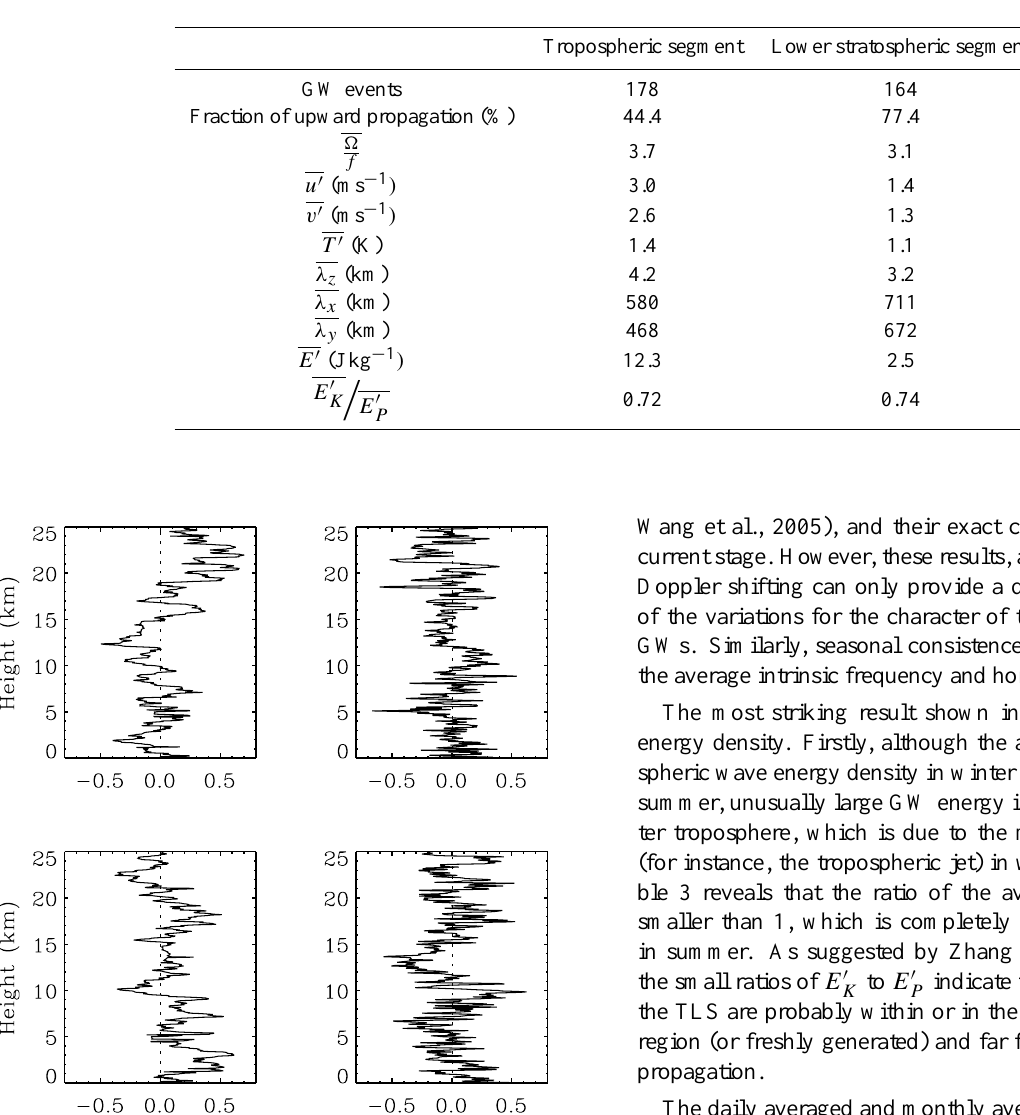
Table 3. Similar to Table 1, but for waves in January 2007.